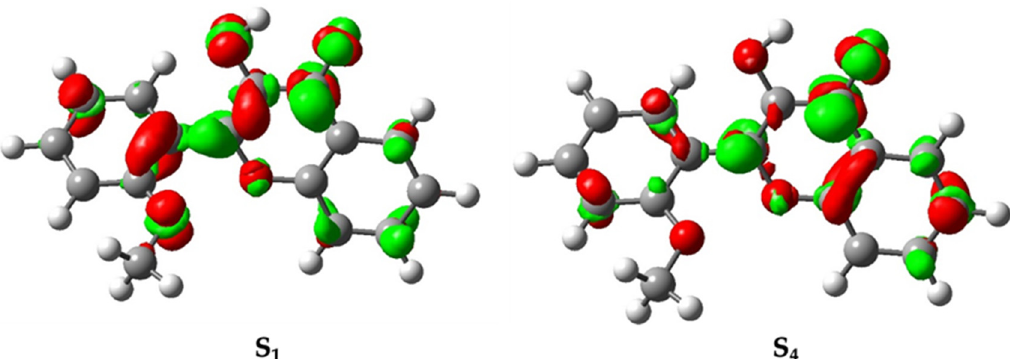
Figure 2. The electron density difference plots for the S 1 and S 4 states for 1b as calculated relative to the S 0 ground state at the TD-B3LYP/6-311G(d) level of theory with SMD models in acetonitrile. The green contours depict the accumulation of electron density in the excited state, and the red contours illustrate the depletion of electron density from the S 0 ground state. The isocontour value is ± 0.0024 au.